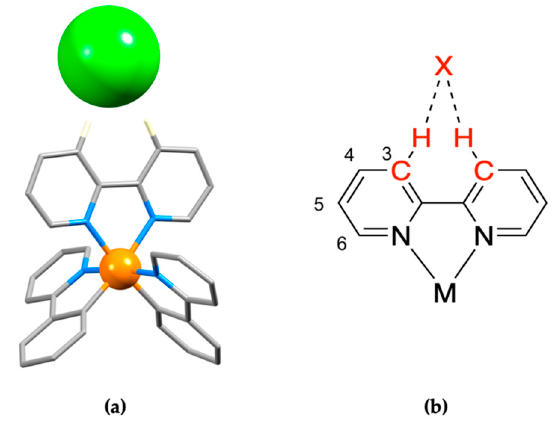
Figure 1. ( a ) The chloride ion interaction with H-3 and H-3’ of the 2,2’-bipyridine ligand in the complex [Ir(bpy)(ppy) 2 ]Cl·2CH 2 Cl 2 ·[H 3 O]·Cl (Hppy = 2-phenylpyridine, bpy = 2,2’-bipyridine) [10]. The chloride ion is shown in a space-filling representation; only the hydrogen atoms involved in the interaction with the chloride ion are shown. The hydrogen atom positions are normalized (C–H = 1.089 Å) and the H…Cl distances are 2.674 and 2.739 Å; ( b ) the generic representation of the bifurcated hydrogen bond to H-3 and H-3’ of a 2,2’-bipyridine ligand. The atoms in red are those used to define the various metrical parameters.